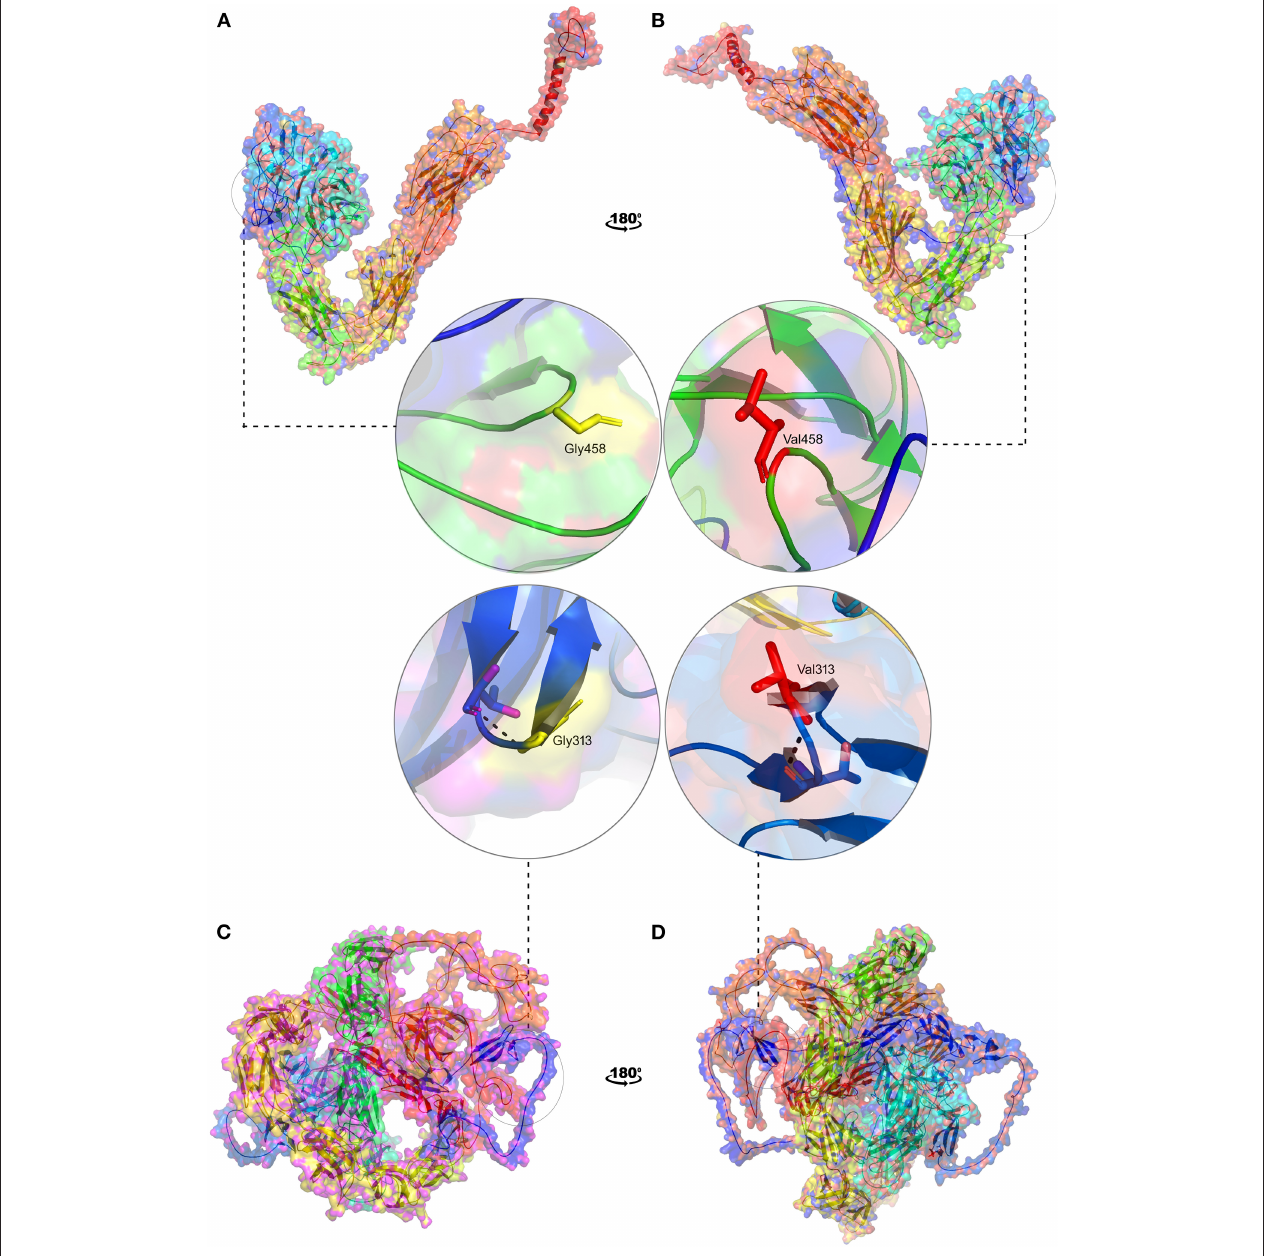
FIGURE 8 | 3D structural representation of TGAV and FN1 wild and mutant types. Magnified structures of (A) ITGAV (Gly458) wild type in yellow (B) ITGAV (Val458) mutant in red and (C) FN1 (Gly313) wild type in yellow (D) FN1 mutant (Val 313) in